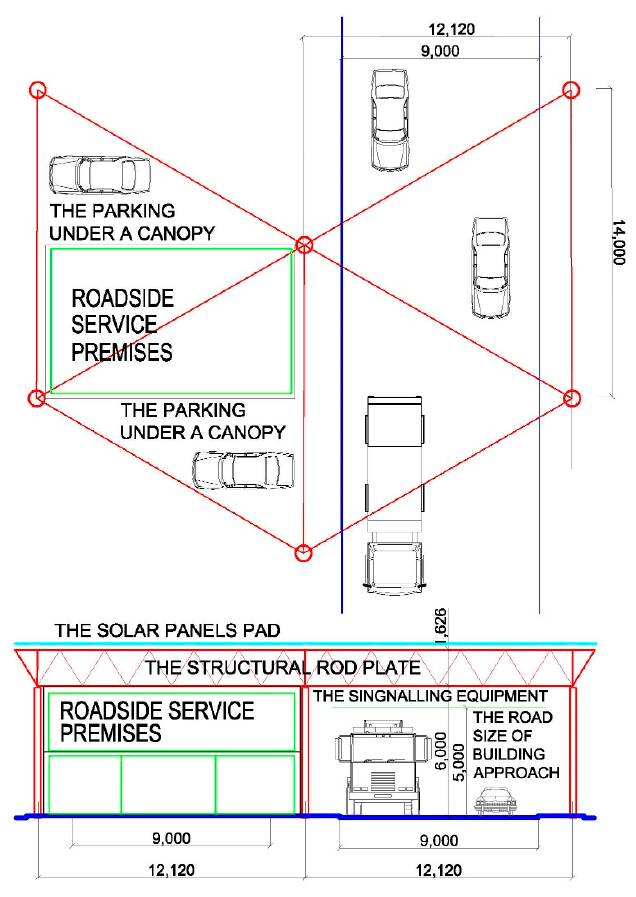
Figure 2. Module parameters: a plan, a section (Dimensions are given in mm).